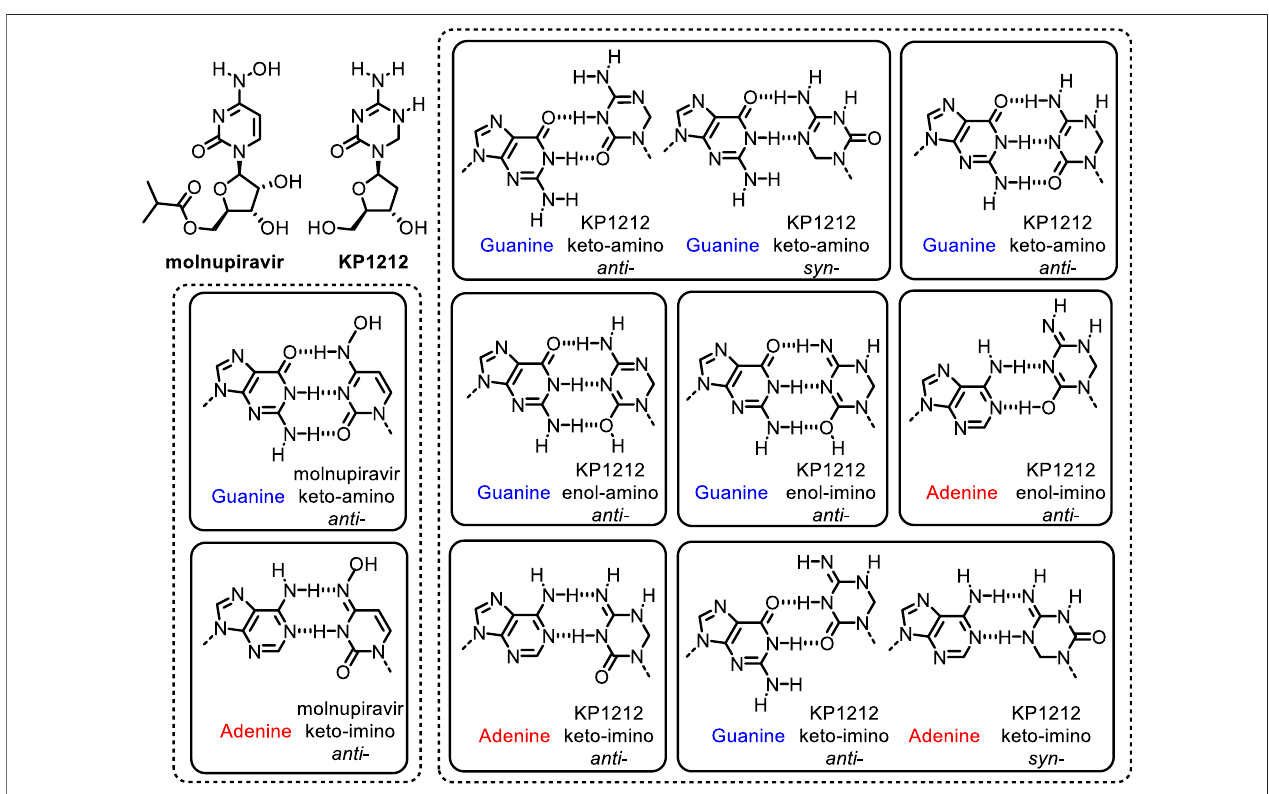
FIGURE 5 | Proposed tautomeric structures of antiviral drugs molnupiravir and KP1212, and base pairing properties during replication in SARS-CoV-2 and HIV viruses, respectively (Li et al., 2014; Kabinger et al., 2021).